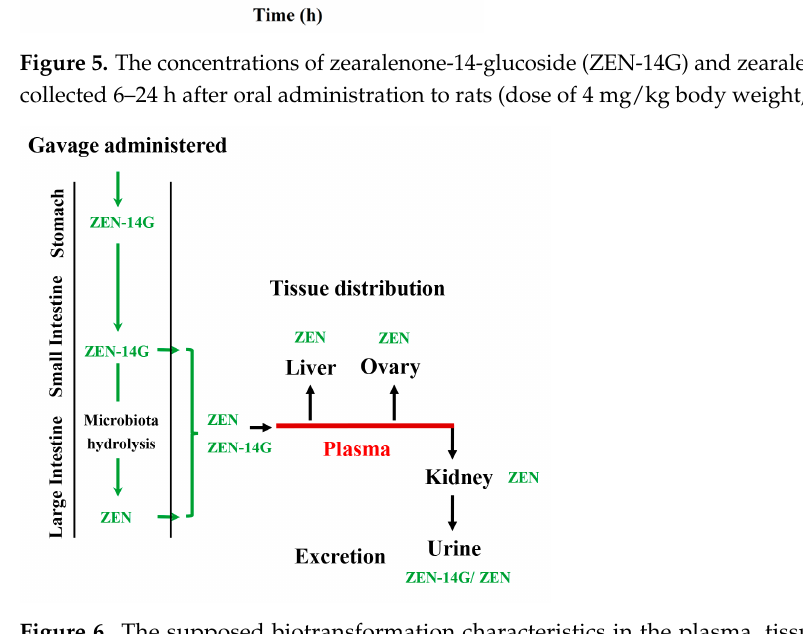
Figure 6. The supposed biotransformation characteristics in the plasma, tissue distribution, and urinary excretion after the administration of ZEN-14G by gavage to